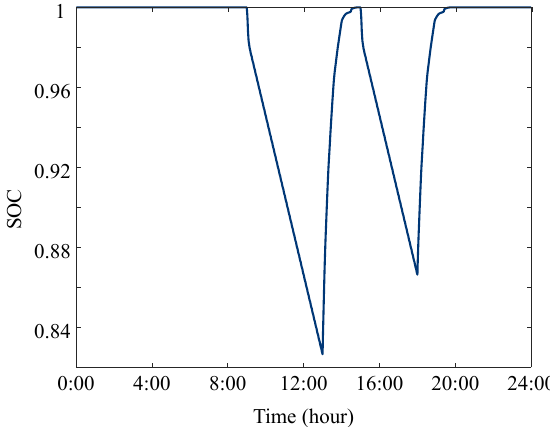
Figure 4. The estimated battery SOC over time with reduced capacity adapter while running an exemplary daily usage profile, which consists of heavy workload profile as shown in Figure 3.